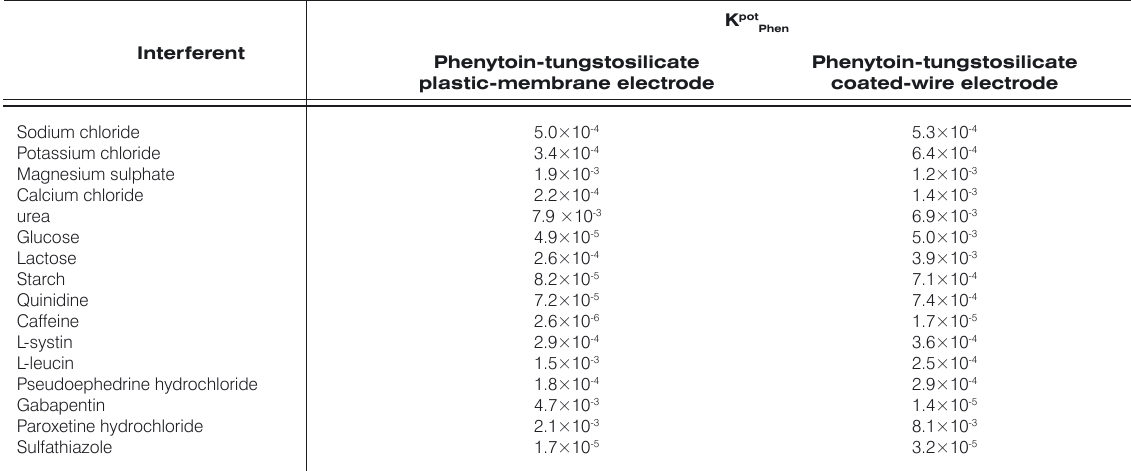
Table 3. Selectivity coefficients of the phenytoin-tungstosilicate sensors calculated